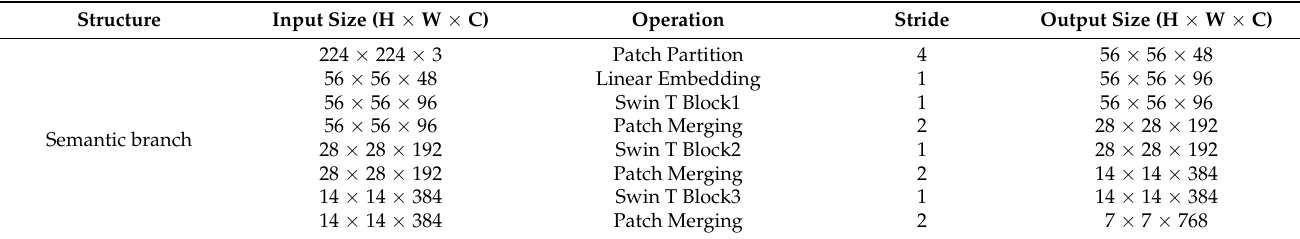
Table 1. Network structure